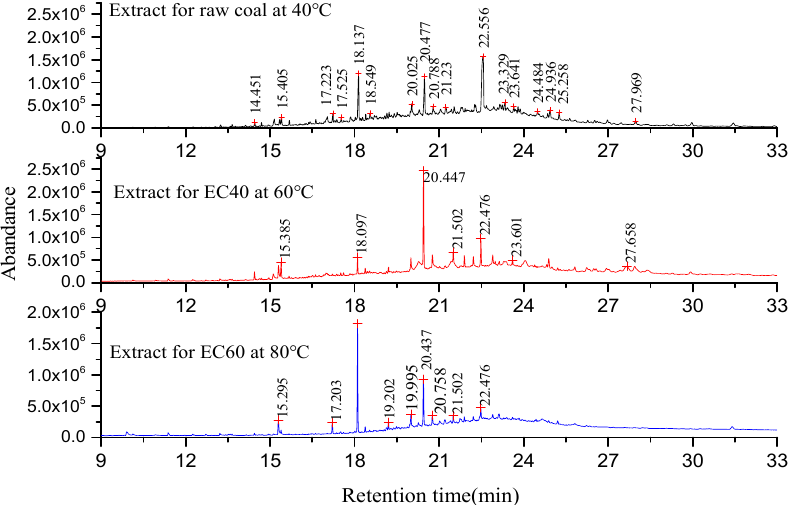
Figure 3. Total ion chromatograms of extracts from Yinni coal.